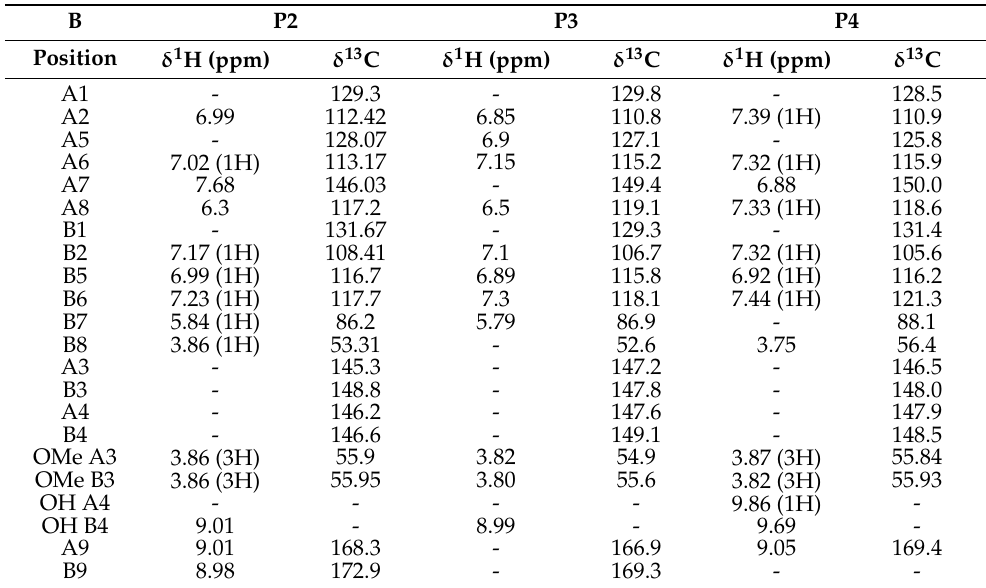
Table 2. 1 H and 13 C NMR data of FA-dehydrodimers of asymmetric P2, P3, P4 (B) at 300 MHz in Dimethyl sulfoxide